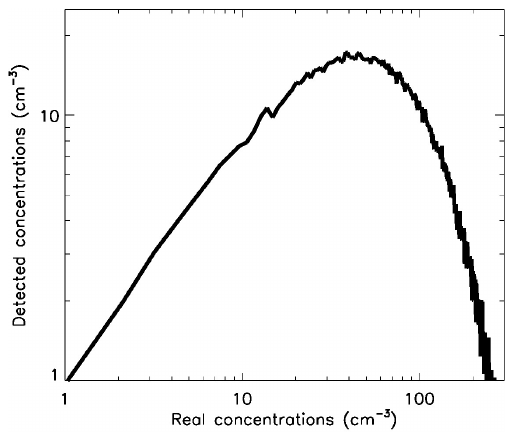
Figure 5. Monte-Carlo modelling for the response of the counting system for particles larger than 1µm. The response is almost linear up to 10particlescm − 3 , and decreases for large